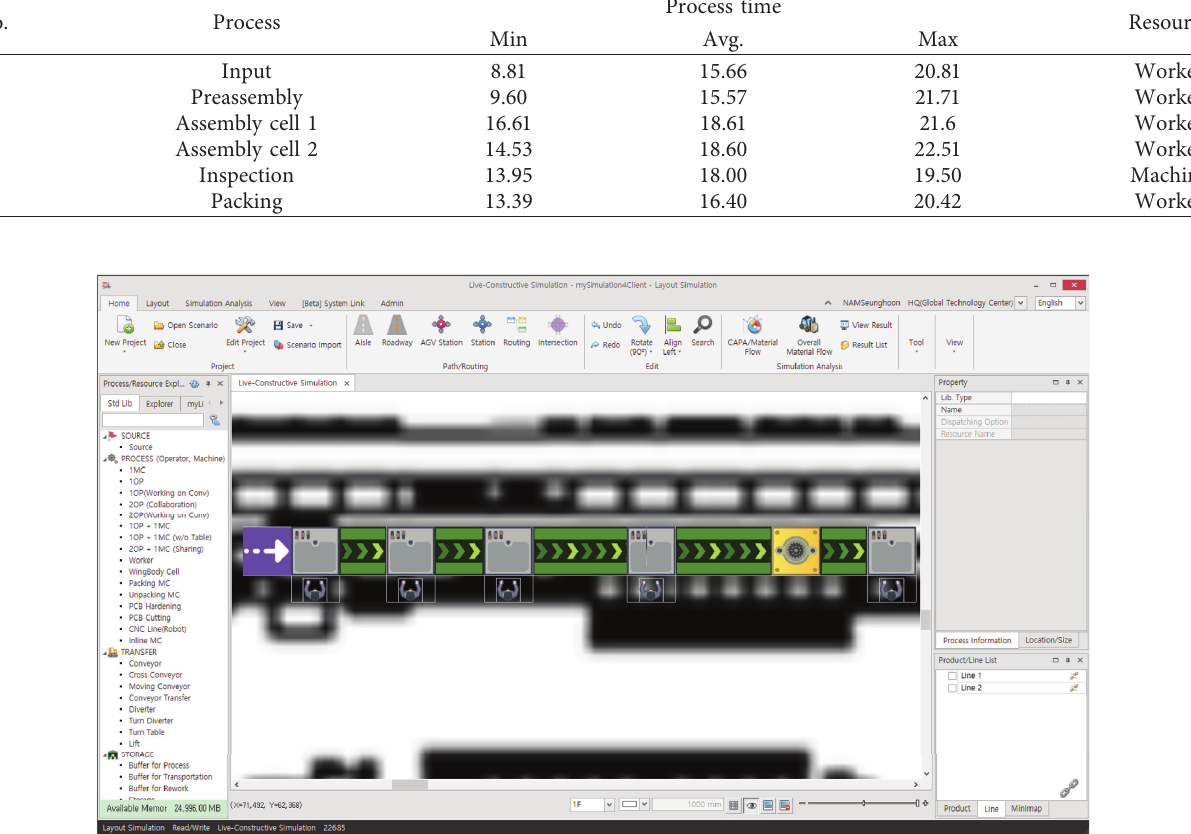
Figure 11: Constructive simulation modeling results for the linear production